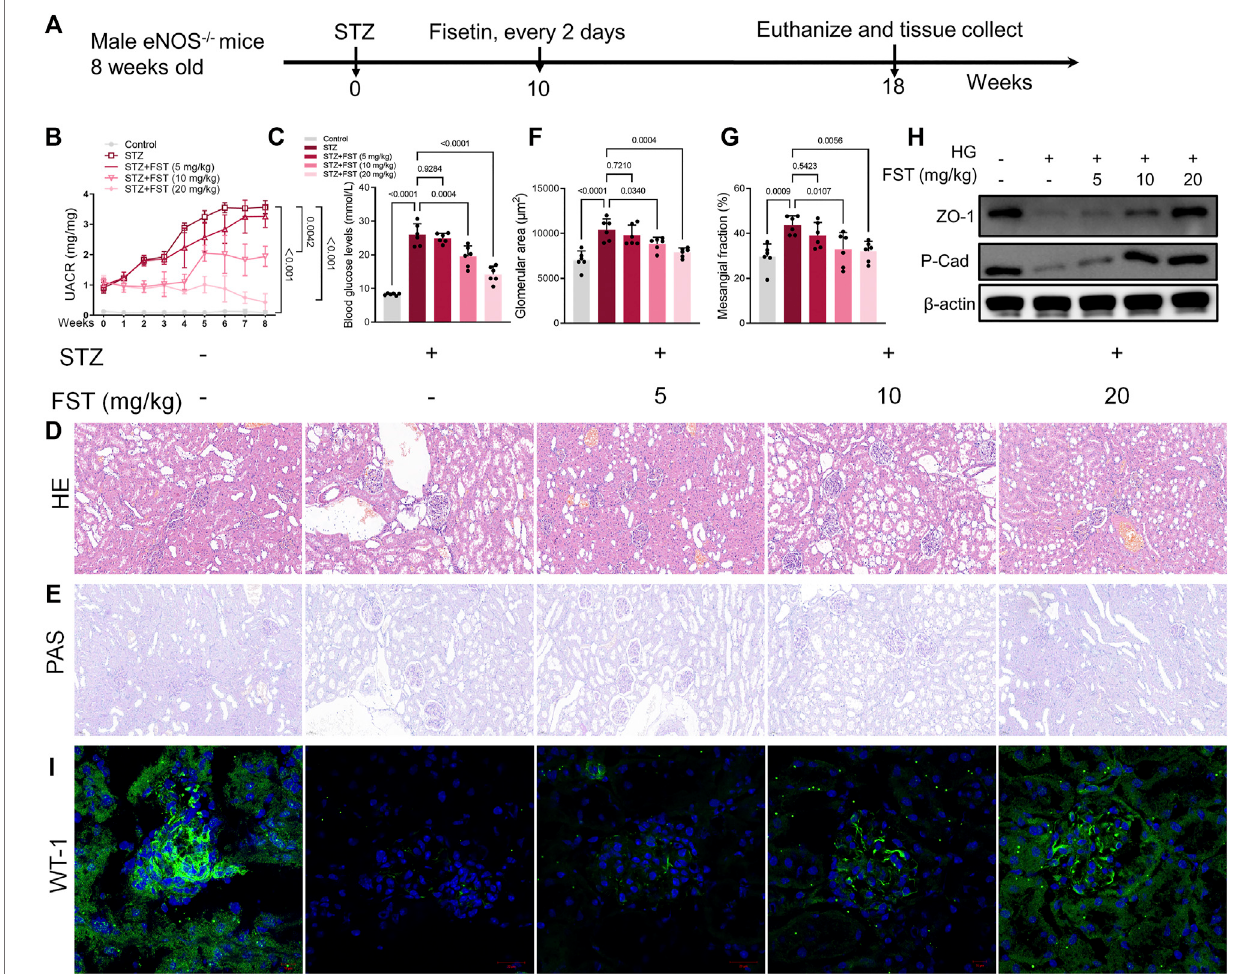
FIGURE5| Fisetinameliorateskidneyinjuryintype1diabeticmice. (A) MaleeNOS − / − micewereinjectedintraperitoneally(i.p.) with50 mg/kgSTZafter6 hoffood deprivationdailyfor fi veconsecutivedaystoinducediabetes.After10 weeks, fi setinwasorallyadministeredtothemiceevery2 daysfor8 weeksandthenthemicewere euthanized. (B) Urinary albumin-to-creatinine ratios (UACR) in mice. (C) The level of blood glucose in mice. (D,E) Representative images of hematoxylin and eosin (H&E; ×200)andperiodicacid – Schiff(PAS;×200)stainedsectionsofkidneytissues.Scalebar=100 μ m. (F,G) Quanti fi cationoftheglomerularandmesangialmatrixarea fractions in mice kidney tissues. (H) Determination of the expression levels of P-cadherin and ZO-1 in mice kidney tissues. (I) Representative images of immuno fl uorescence-stained sections of WT-1 (×200) of mice kidney tissues. Data are expressed as means ± SEM ( n = 6).